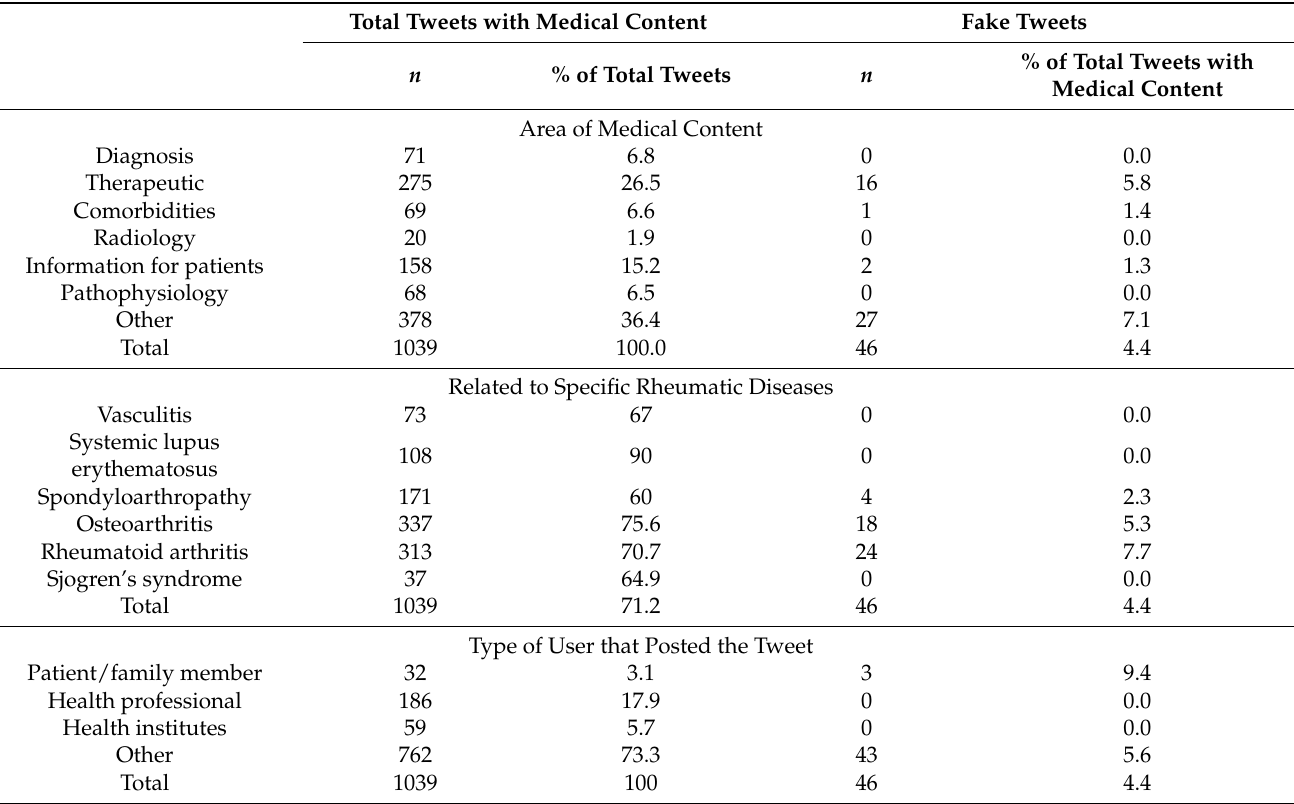
Table 2. Number of tweets with medical contents and of those with fake information related to the rheumatic diseases. Total Tweets with Medical